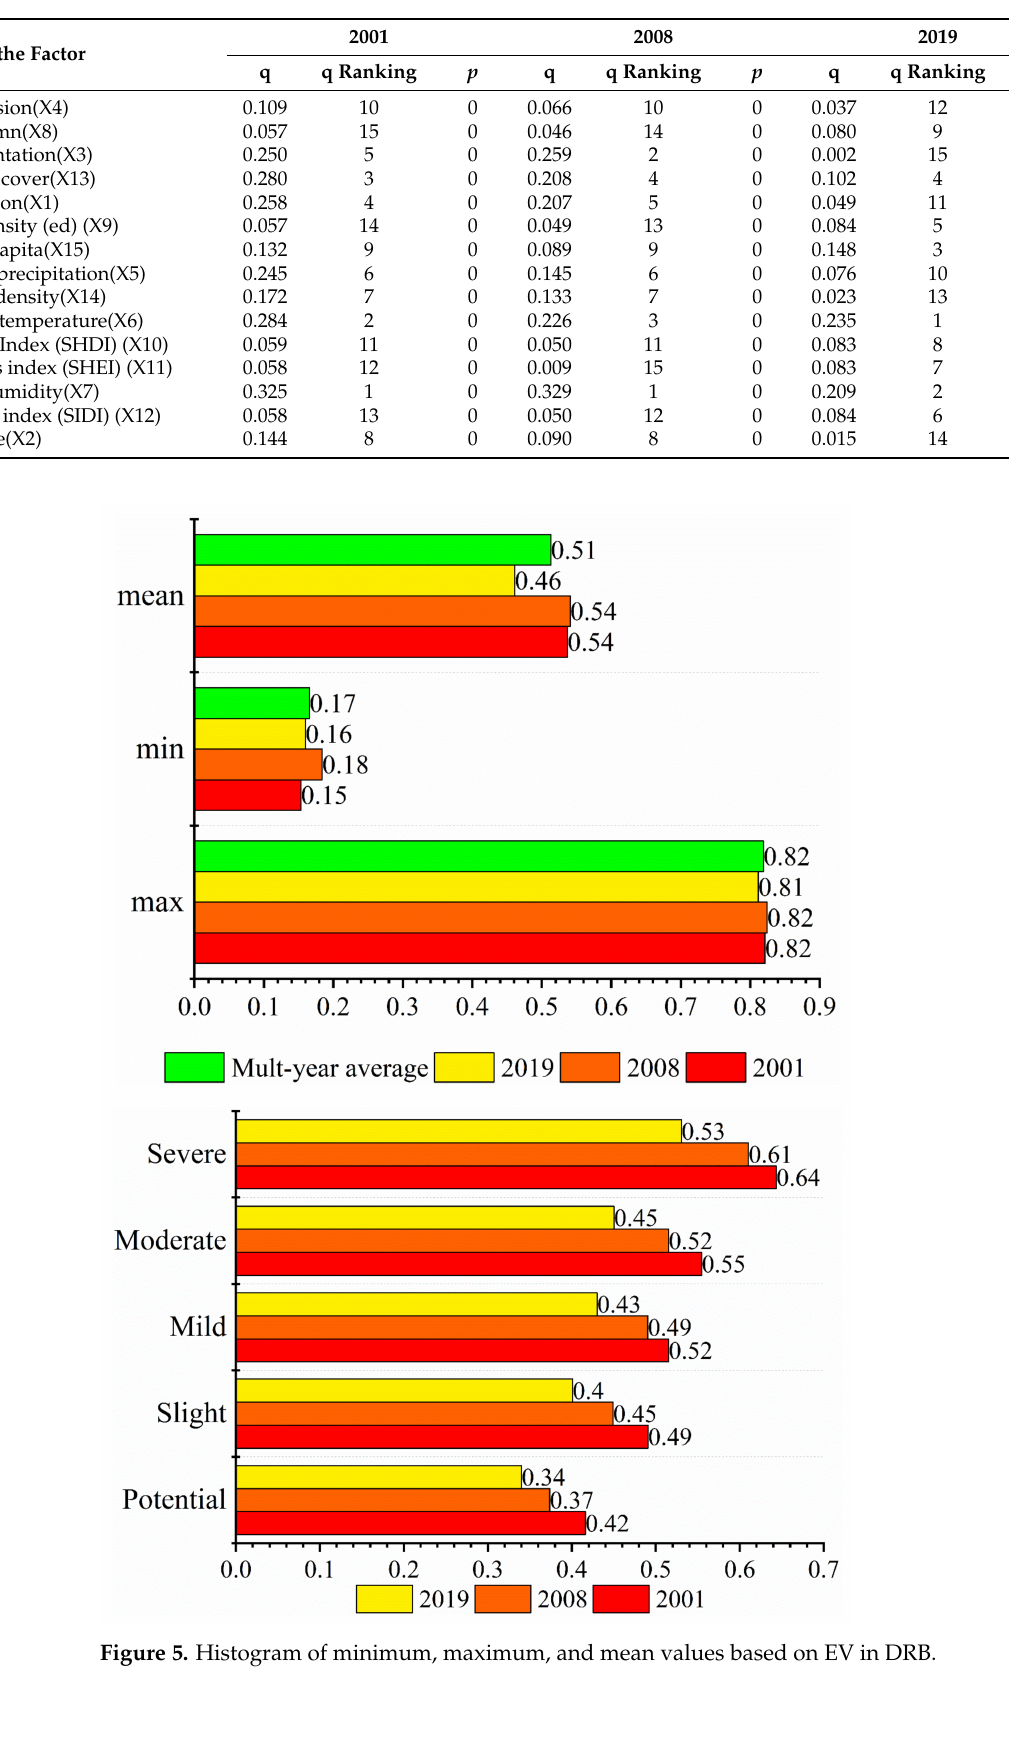
Table 5. Statistics of q-values for ecological vulnerability factor detection.